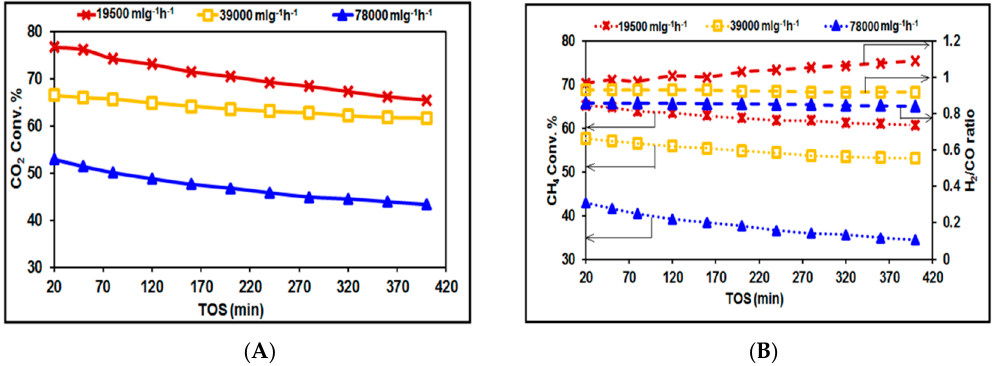
Figure 8. ( A ) CO 2 conversion for Ti-CAT-II at different gas hourly space velocity ( B ) CH 4 and H 2 /CO ratio for Ti-CAT-II catalyst at different space